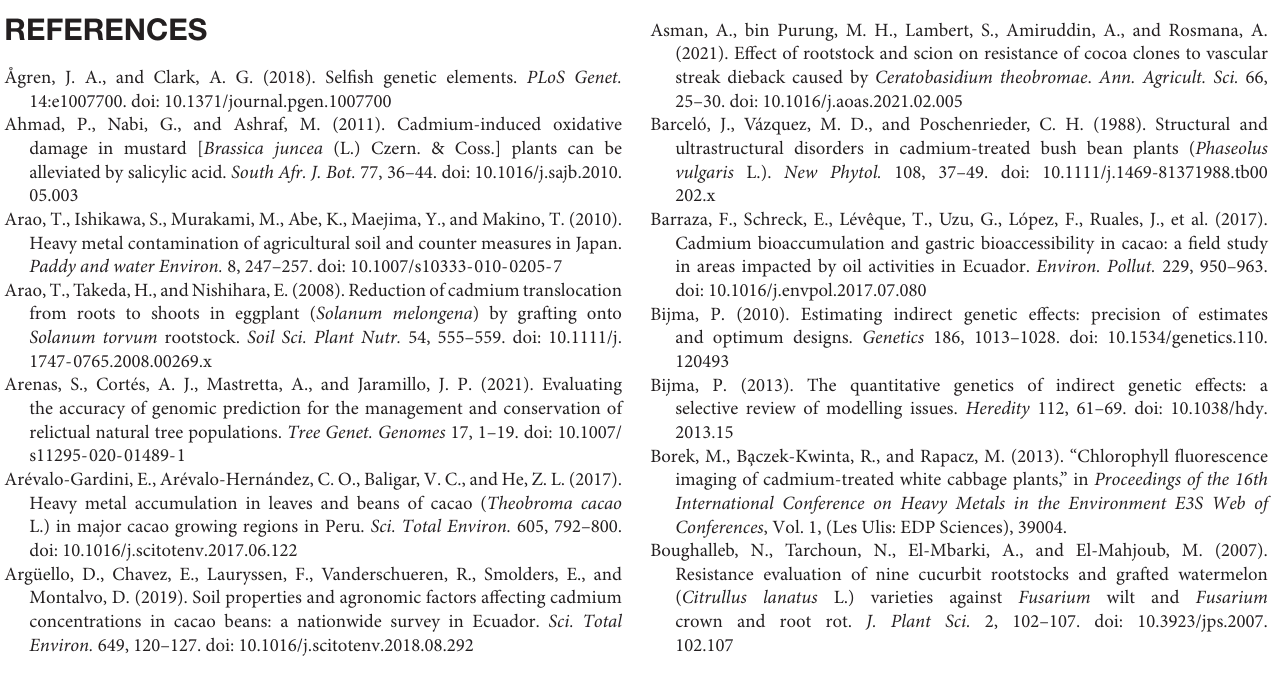
grafting, and (B) two and (C) four months after grafting with the ICS95 and CCN51 clonal scions under two Cd treatments. Supplementary Table 1 | Concentration of mineral nutrients in leaf tissue of ungrafted rootstocks five months after cadmium treatment. Different lowercase letters indicate significant differences in mineral elements concentration between ungrafted seedling families at the same Cd concentration in soil. Different capital letters indicate significant differences in mineral elements concentration of the same ungrafted seedling at different Cd concentrations in soil. Results are according to Duncan test ( p < 0.05). Data are mean values ± SE ( n = 8). Supplementary Table 2 | Concentration of mineral nutrients in leaf tissue of scions ICS95 and CCN51 two months after grafting onto rootstocks. Different lowercase letters indicate significant differences in mineral elements concentration in leaf tissue of the ICS95 or CCN5 clonal scions grafted on four different seedling rootstock families at the same Cd concentration in soil. Different capital letters indicate significant differences in mineral elements concentration in leaf tissue of ICS95 or CCN51 clonal scions grafted on the same seedling rootstock family at different Cd concentrations in soil. Results are according to Duncan test ( p < 0.05). Data are mean values ± SE ( n = 8). Supplementary Table 3 | Specific combining abilities in cacao seedlings from controlled crosses before grafting. Estimates were gathered in two OP half-sib families (IMC67 and PA121), and two full-sib progenies obtained from the crossing between IMC67 × PA121 and its reciprocal cross, under two Cd treatments. Specific combining abilities are indexed to a general mean (intercept under the first column after the p -value), and the corresponding positive or negative contributions (three last columns). Significantly different specific combining abilities are highlighted. Supplementary Table 4 | Narrow-sense heritability (h2) in cacao seedlings from controlled crosses before grafting. Estimates were gathered in two OP half-sib families (IMC67 and PA121), and two full-sib progenies obtained from the crossing between IMC67 × PA121 and its reciprocal cross, grafted with the ICS95 and CCN51 clonal scions under two Cd treatments. Heritability ( h 2 ) and model fits ( r ) estimates were computed using an A pedigree relatedness matrix ( Supplementary Figure 2A ) inputted in a “genetic prediction” additive mixed linear model, according to de los Campos et al. (2009). Heritability ( h 2 ) scores above 0.1 are highlighted.